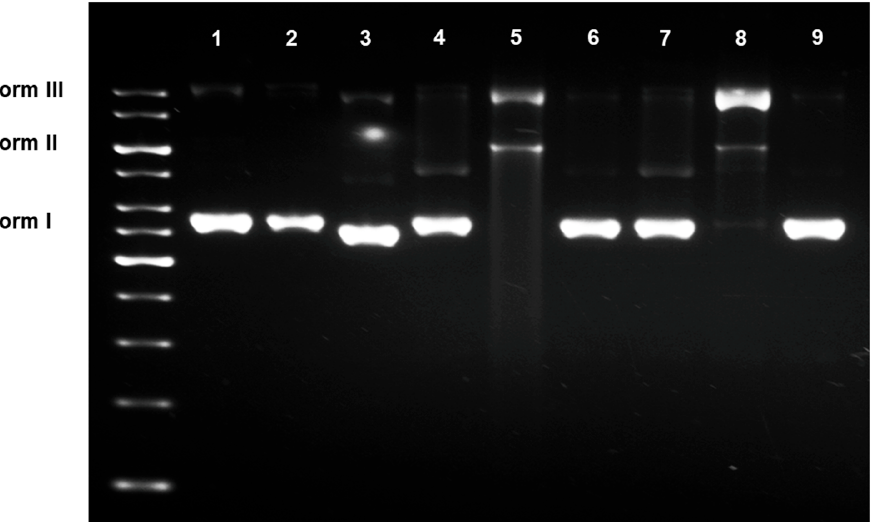
Figure 1. Effects of compounds 1 – 6 on plasmid DNA; lanes (1) DNA; (2) DNA + DMSO; (3) DNA + cisplatin (10 mM); (4–9) DNA + compounds 1 – 6 (10 mM, each),